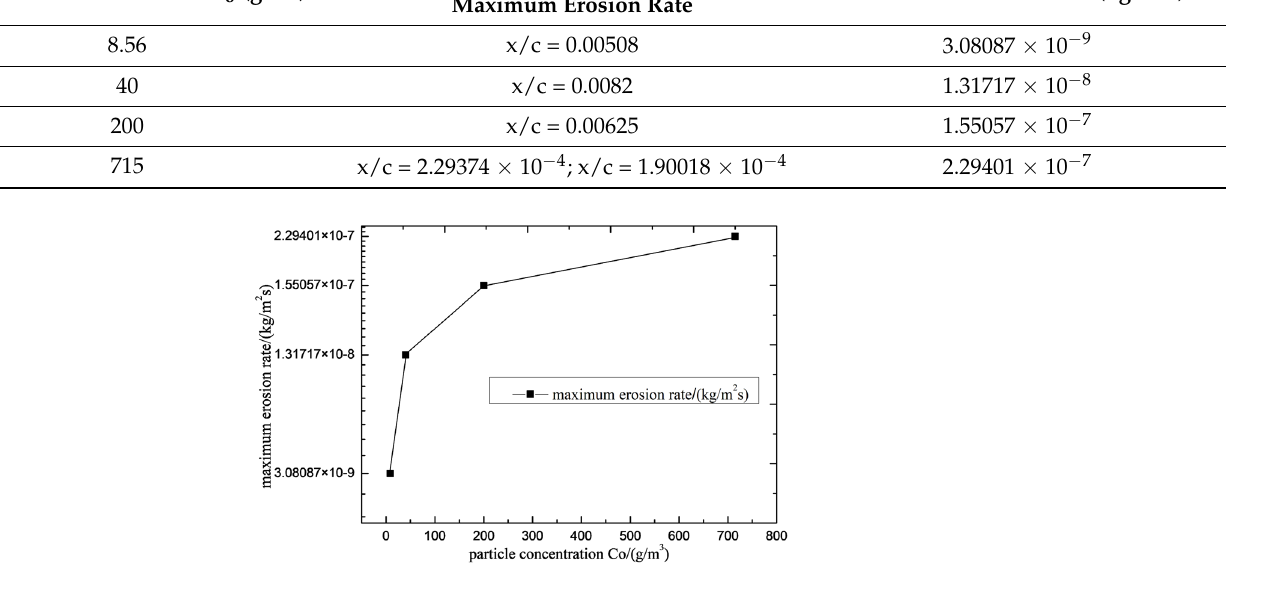
Figure 13. Variation curve of maximum erosion rate of the airfoil with particle concentration.